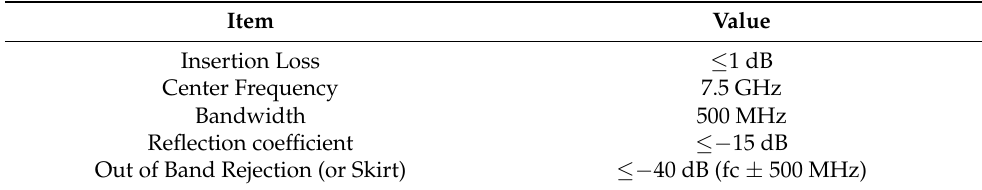
Table 1. Specifications the design will meet.